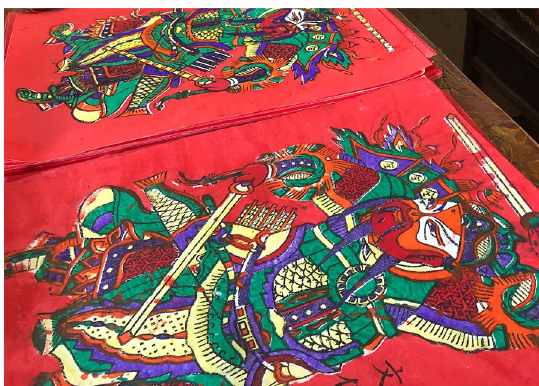
Fig. 6 Door God Woodblock prints. (authors ’ photo,